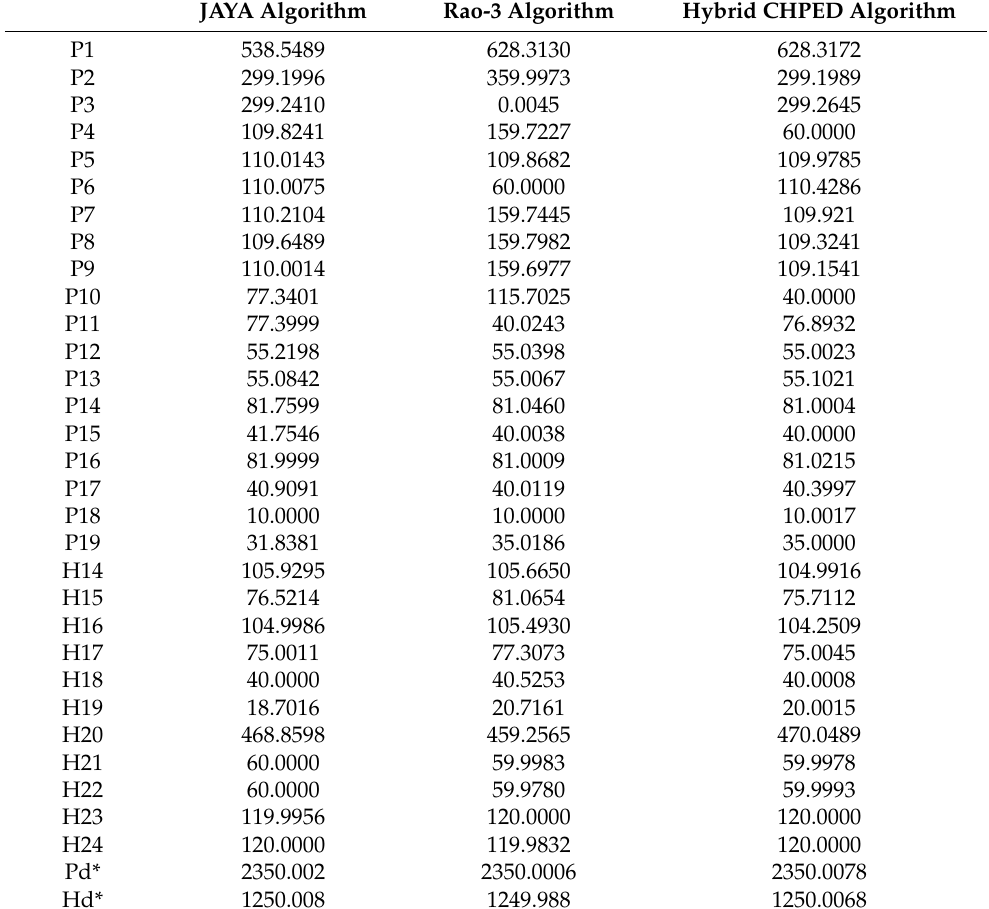
Table 3. Optimised values of the power-heat production for case 1 of test system 2.